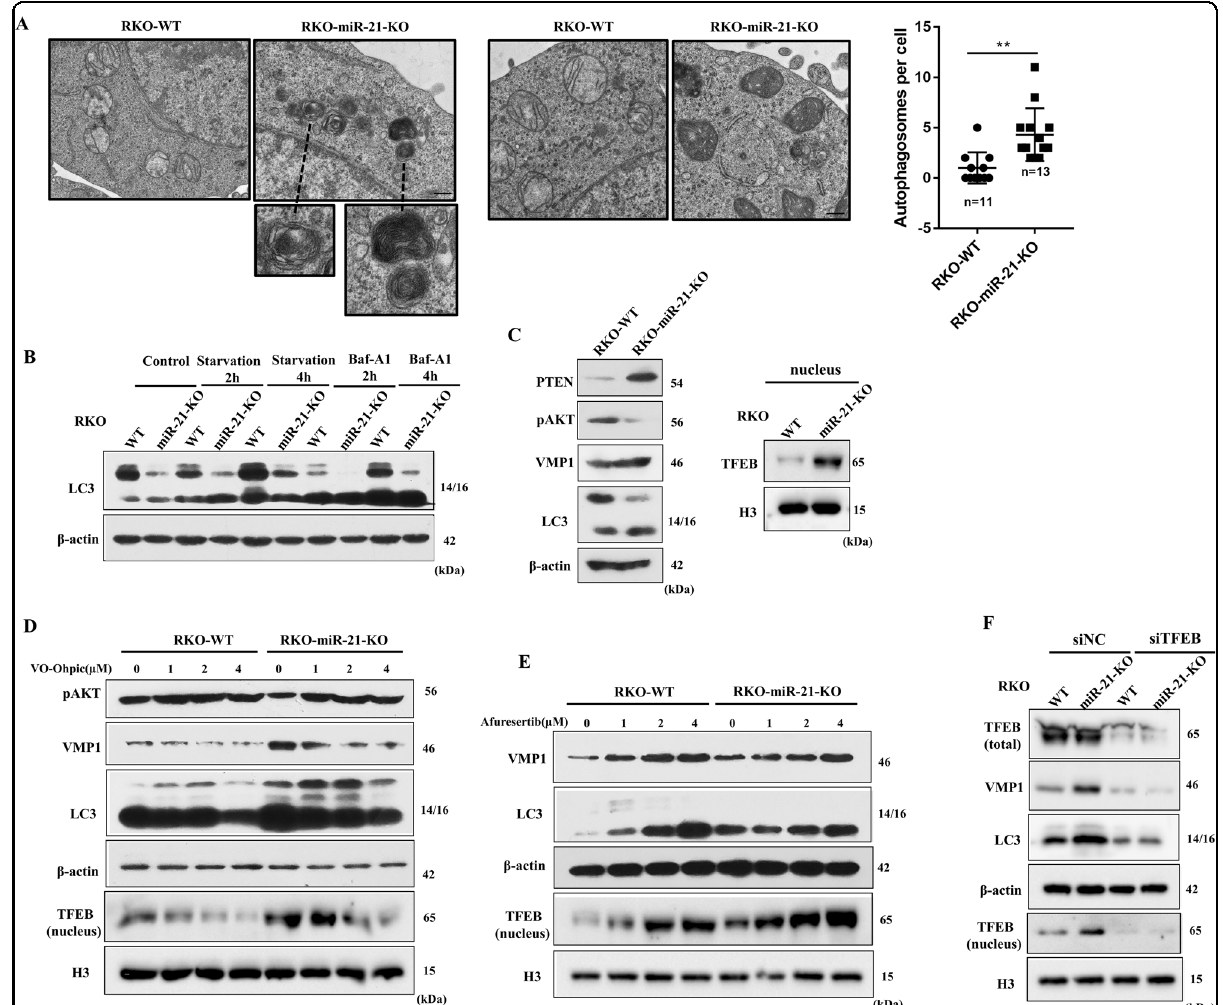
Fig. 5 miR-21 regulates the autophagy of colorectal cancer cells through PTEN/AKT/TFEB. a Autophagic structures (AV, AL, and IM) were observed in parental RKO and RKO-miR-21-KO cells by transmission electron microscope. Number of autophagic structures was counted. b RKO and RKO-miR-21-KO were treated with glucose starvation or ba fi lomycin A1, the LC3 (LC3I and LC3II) expression was measured by Western blot. c The protein expression level of PTEN, phosphorylated AKT (Ser473), VMP1, LC3, and nuclear TFEB were measured by Western blot in RKO and RKO-miR-21- KO cells. d RKO and RKO-miR-21-KO were treated with VO-Ohpic at concentrations of 1 – 4µM for 24 h, and immunoblot analysis of phosphorylated AKT (Ser473), VMP1, LC3 expression and the protein amount of nuclear TFEB. e RKO and RKO-miR-21-KO were treated with Afuresertib at concentrations of 1 – 4 µM for 24 h, and immunoblot analysis of VMP1, LC3 expression, and the protein amount of nuclear TFEB. f The protein expression level of VMP1, LC3, total TFEB, and the protein amount of nuclear TFEB were measured by Western blot after knock-down of TFEB expression by siRNA in RKO and RKO-miR-21-KO cells. (Scale bars, 0.5 µm) Data are presented as mean ± SD. ** P <